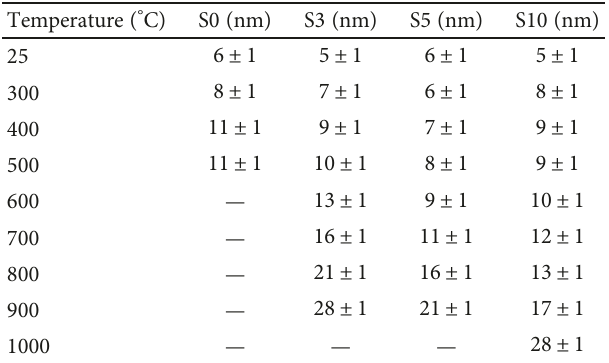
Table 2: Crystallite size for S0, S3, S5, and S10 thermally treated at di ff erent temperatures, calculated by using Scherrer ’ s